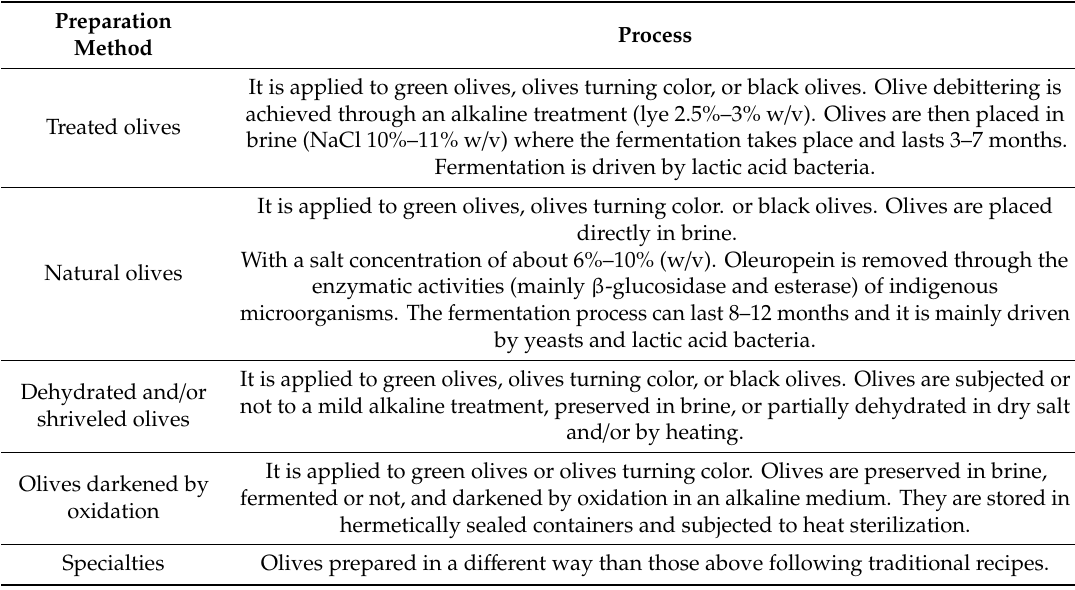
Table 1. Olive processing methods according to the International Olive Oil Council (IOOC)